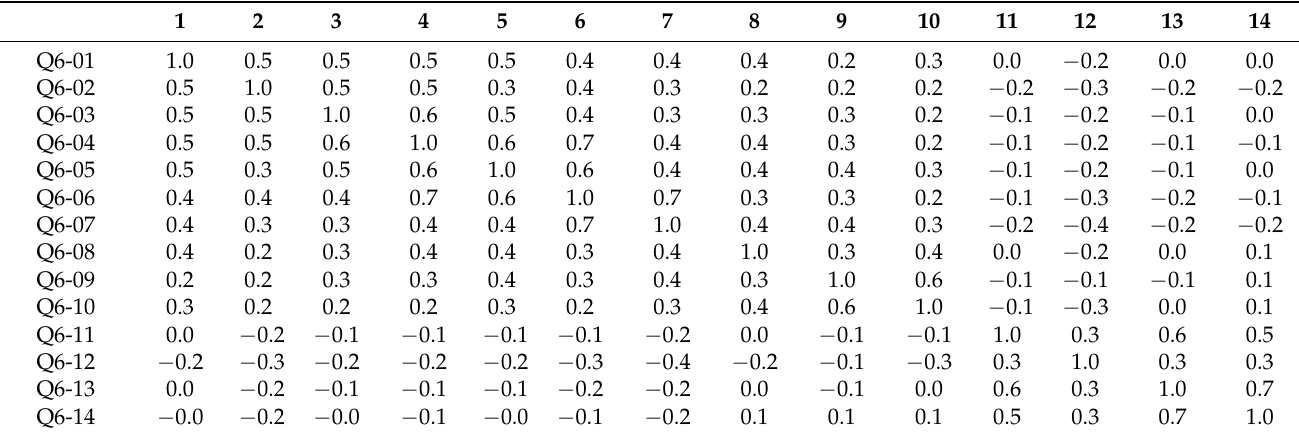
Table 5. Cross-correlation coefficients. Lithuanian